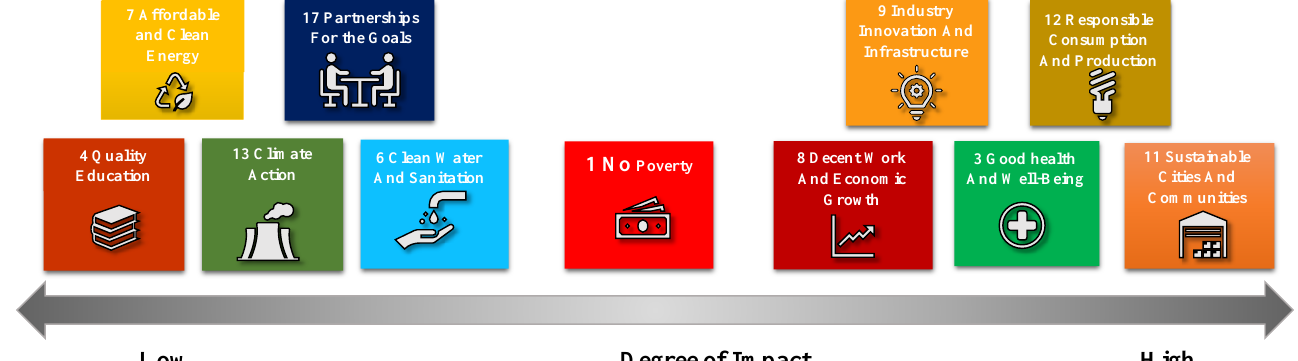
Figure 1. Impact of 3DCP on the SDGs.